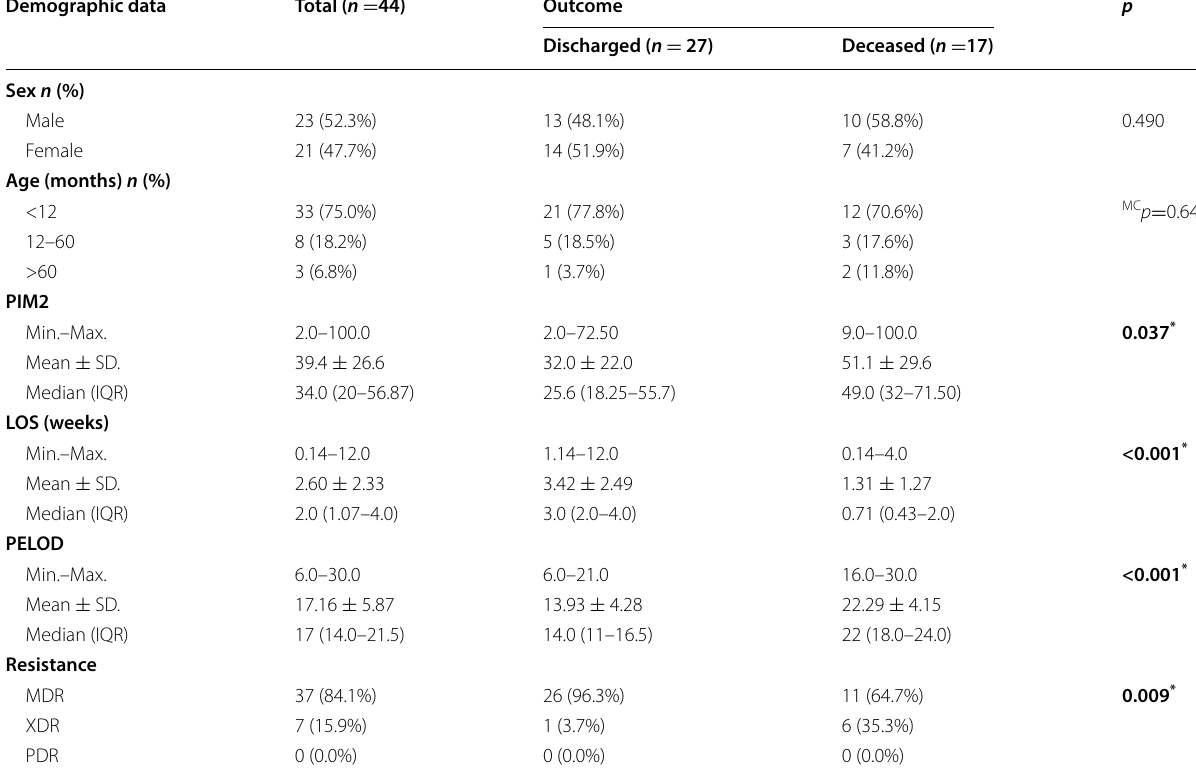
Table 1 Comparison between the studied groups according to demographic data